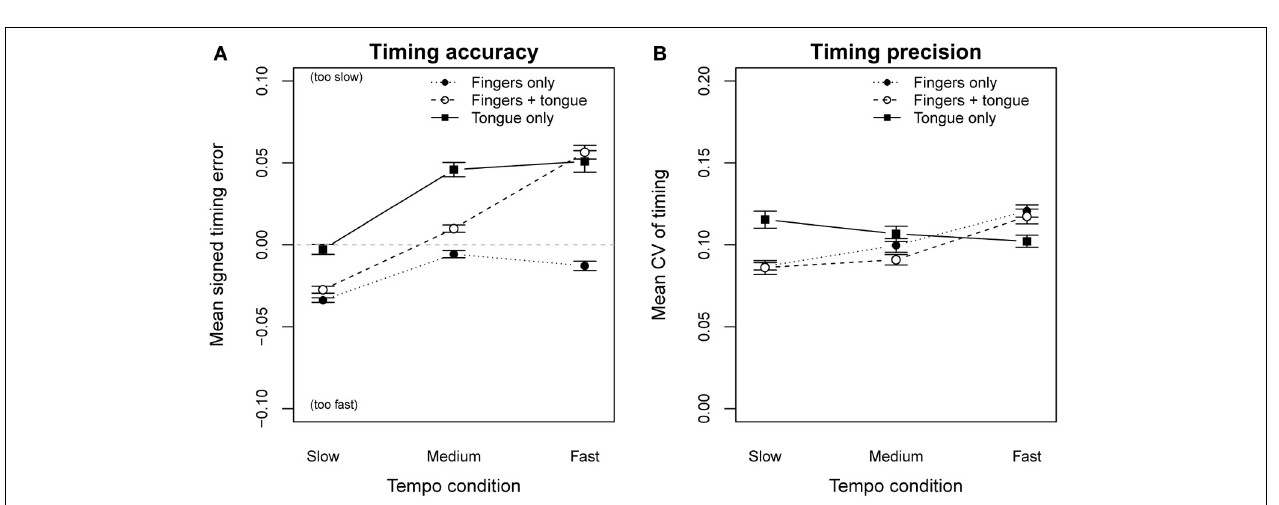
FIGURE 6 | Timing error (A) and coefficient of variation (B), grouped by effectors used to produce tone onsets. Error bars show the standard error of the mean.